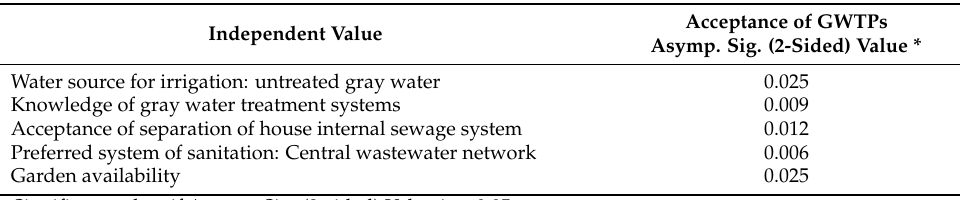
Table 3. Acceptance of construction GWTPs in rural areas.